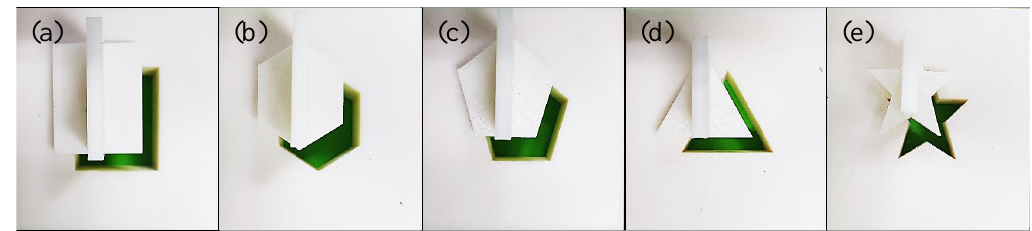
Figure 5. Five pegs and five holes with: ( a ) rectangle; ( b ) hexagon; ( c ) pentagon; ( d ) triangle; and ( e ) star